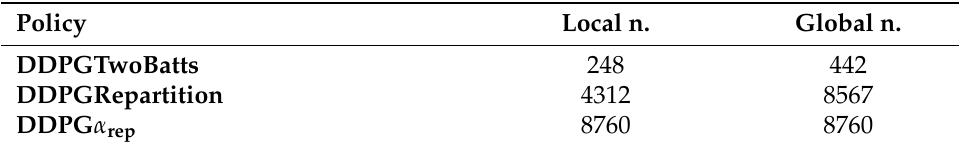
Table 5. Learned policies duration depending on the reward normalization: local or global. Using simulations on 2007 test